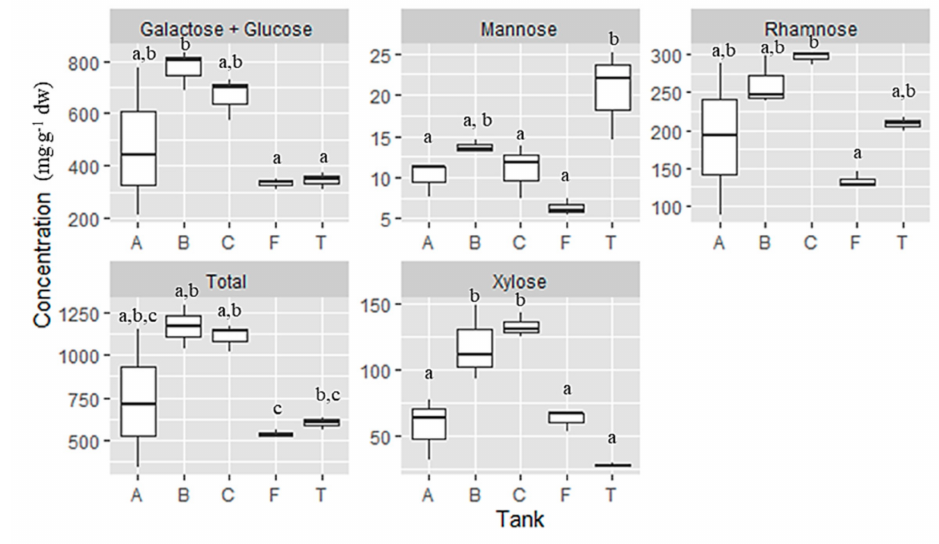
Figure 6. Graphs of monosaccharide composition expressed in mg · g − 1 d.w. of Ulva sp. obtained from different cultivation tanks or wild: indoor aquaria (A, B, and C) outdoor tank (T) and harvested from the field (F). In each graph same upper letters (a, b, and c) mean there are no significant differences between the treatments (cultivation type). Data as mean value distribution and variance; n =